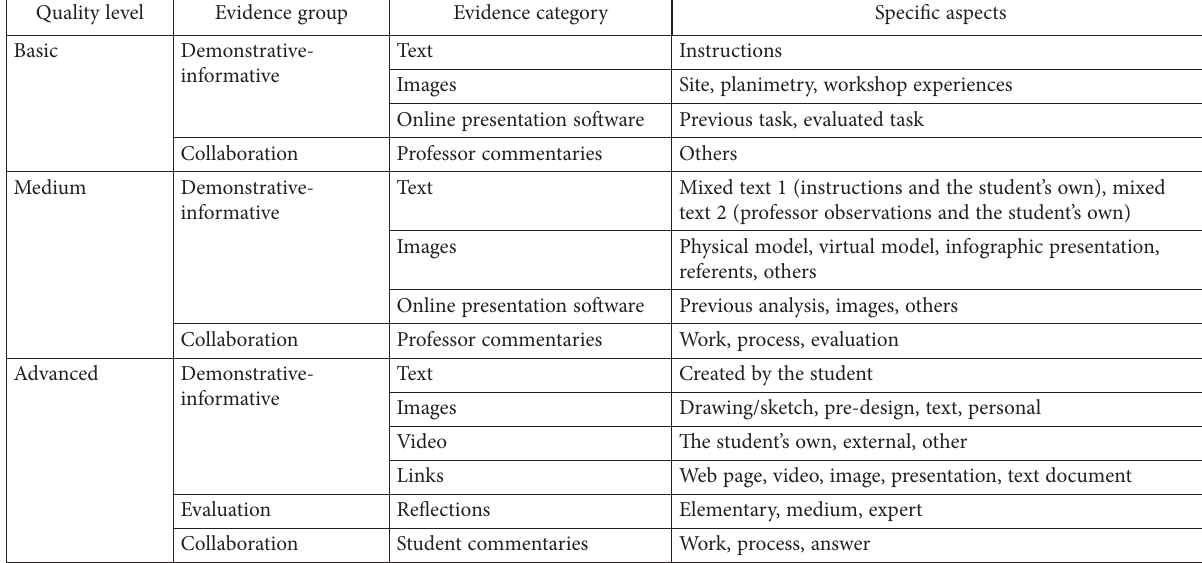
Table 5. Quality levels of the architectonic evidence (source: Authors,